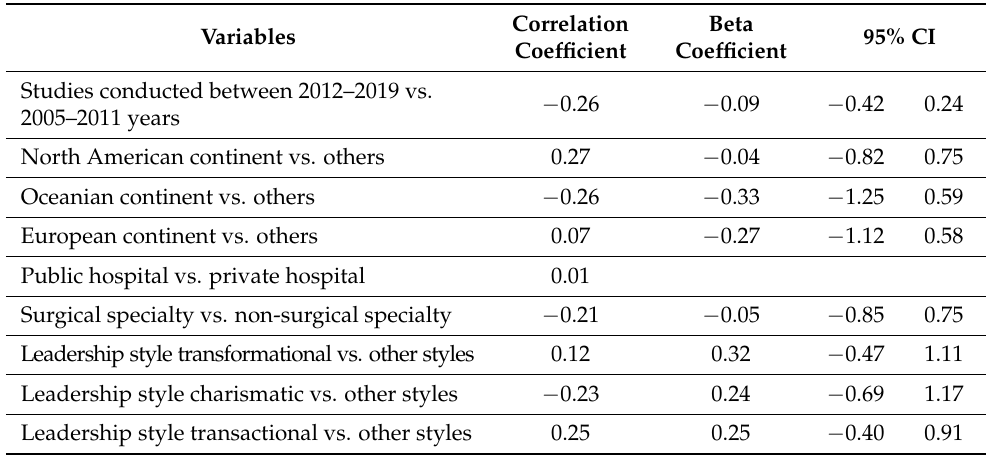
Table 1. Correlation coefficients and multi-regression analysis of leadership effectiveness in before– after studies. Variables